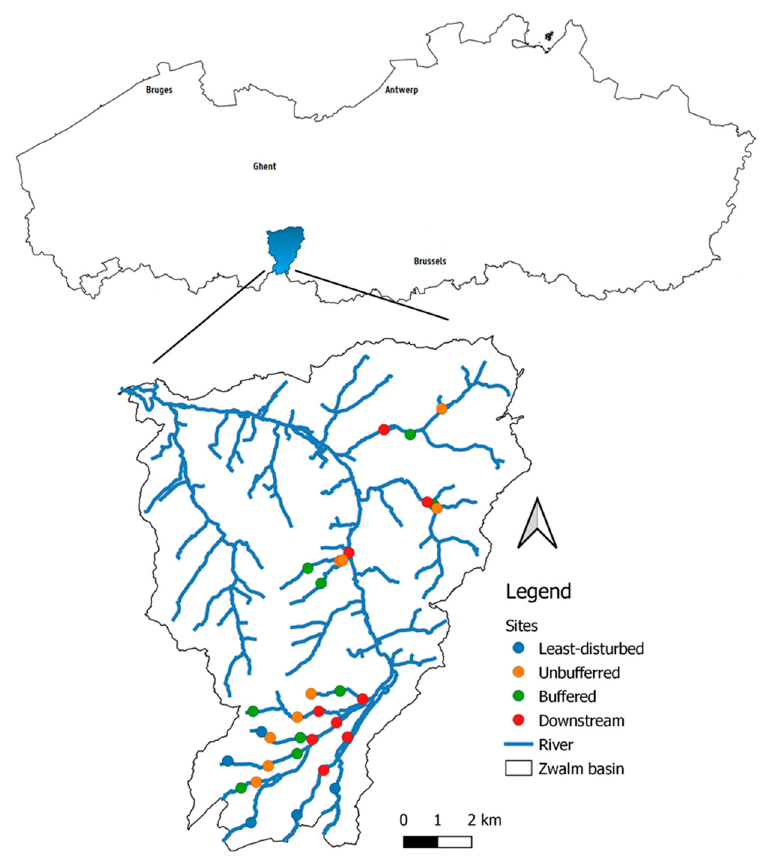
Figure 1. Locations of the sampling sites within the Zwalm River basin.